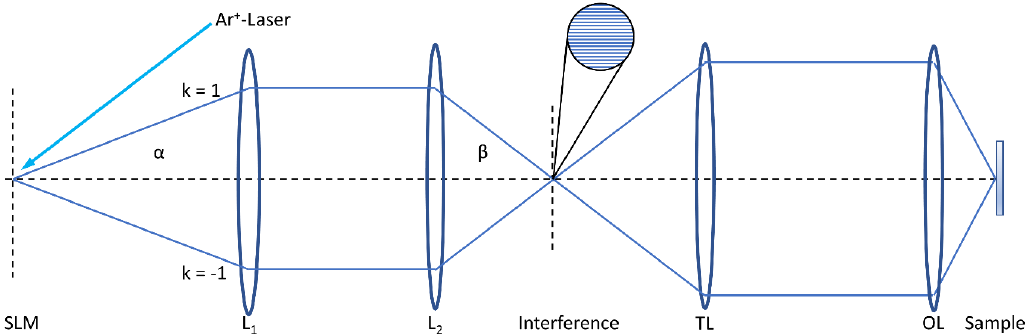
Figure 1. SIM (schematic) with spatial light modulator SLM (illuminated by an argon ion laser), telescope lenses L 1 , L 2 , tube lens TL and objective lens OL. Further components ( λ /4 plate, pinhole plate, polarizer, dichroic mirror and camera are omitted). If the two interfering laser beams are incident close to the edges of a high aperture OL, SIM may be combined with Total Internal Reflection Microscopy (TIRFM), as reported below. Reproduced from [15] with modifications.